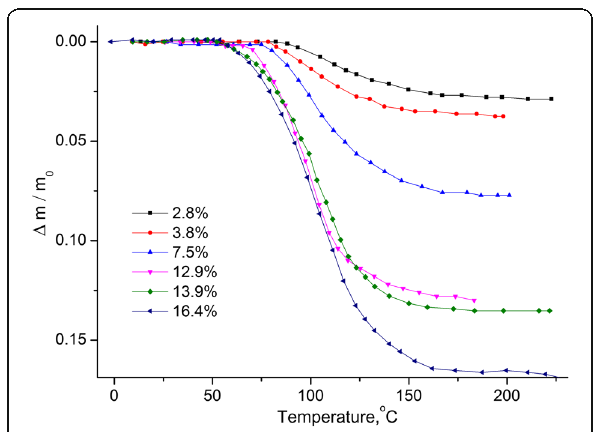
Fig. 1 Temperature dependence of the relative mass change of MCC. Temperature dependence of the relative mass change Δ m / m 0 of MCC samples with different water content